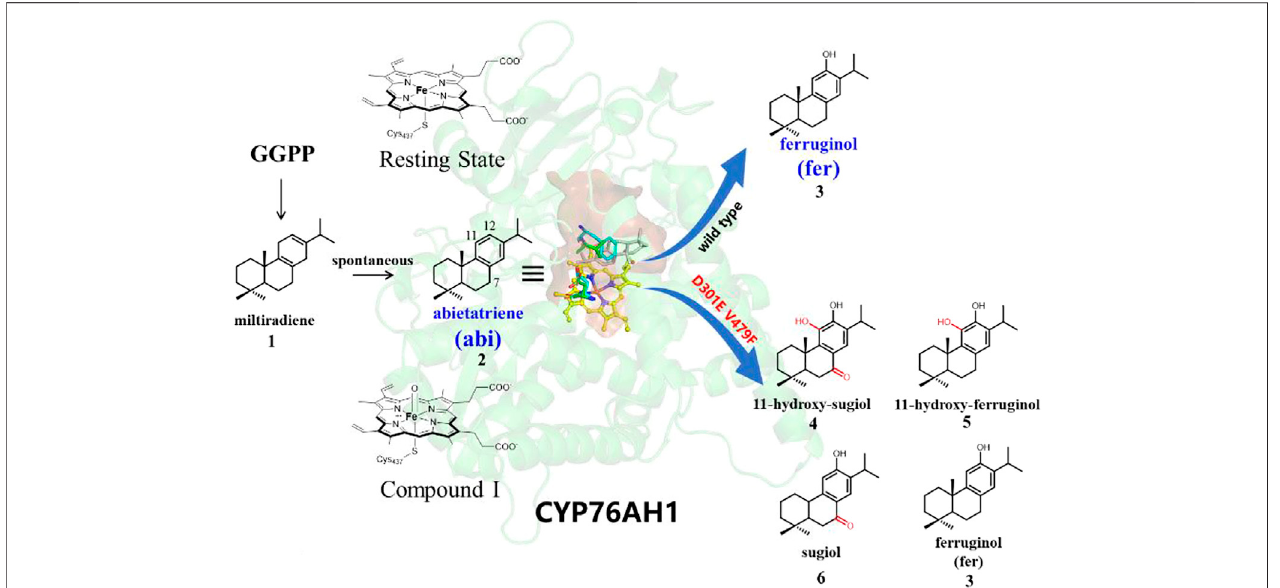
FIGURE 1 | Product fi delity and promiscuity in wild-type and mutant CYP76AH1.